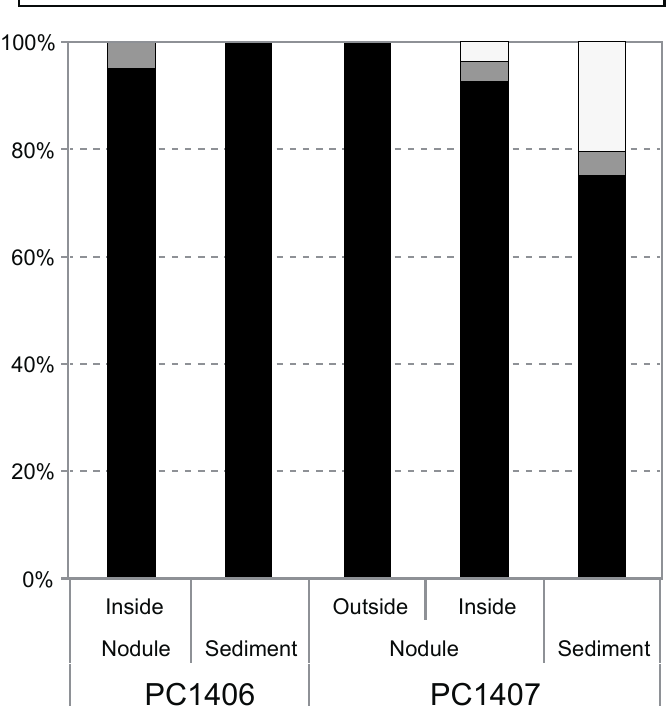
Figure 4. Phylogenetic compositions of mcrA genes detected at PC1406 and PC1407 samples.